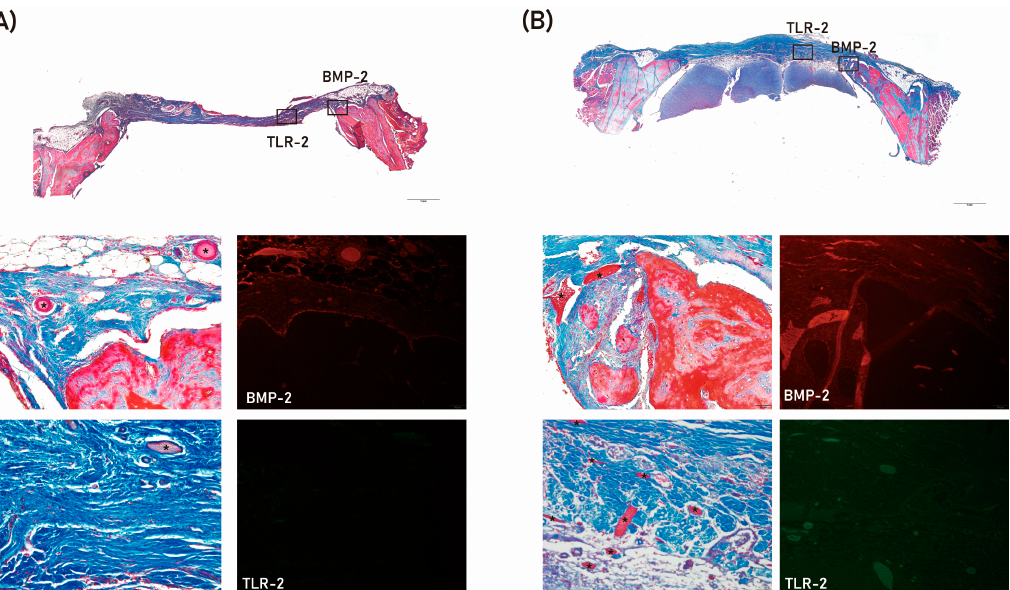
Figure 4. Histologic and immunofluorescence analysis of tissue samples from the S group ( A ) and the S+4HR group ( B ). Tissue sections were stained with Masson trichrome and viewed at magnifications of ×20 and ×200. BMP-2 and TLR-2 expression are shown as rectangles on the low magnification views. Remaining grafts (*) were stained red.